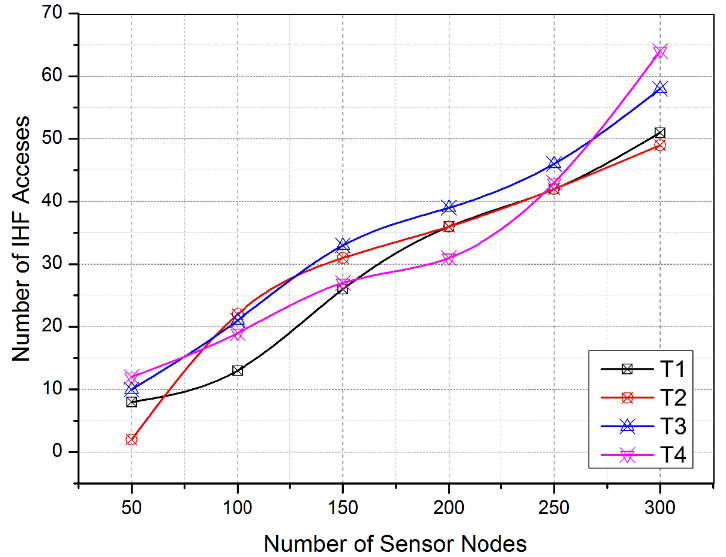
Figure 9. Number of IHF Accesses.